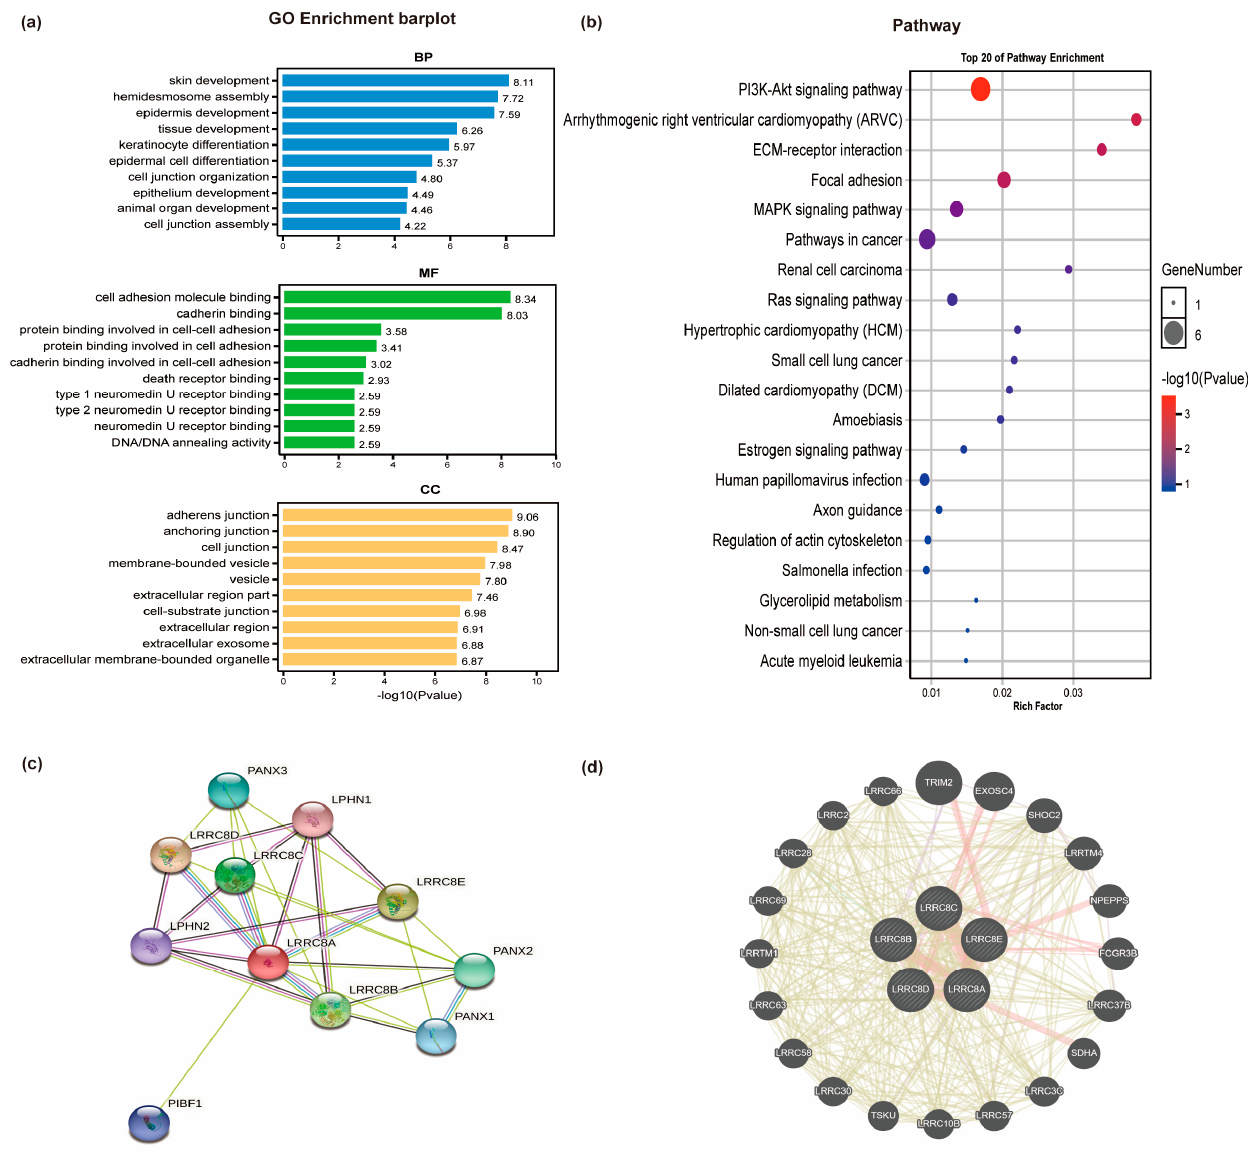
Figure 3. Function analysis of LRRC8A in PAAD. ( a ) GO enrichment analysis (biological process, molecular function, and cellular component) of the top 50 positively correlated genes of LRRC8A; ( b ) KEGG enrichment analysis of the top 50 positively correlated genes of LRRC8A; ( c ) protein interaction network of LRRC8A–E; ( d ) gene–gene interaction network of LRRC8A–E and the top 50 positively correlated genes of